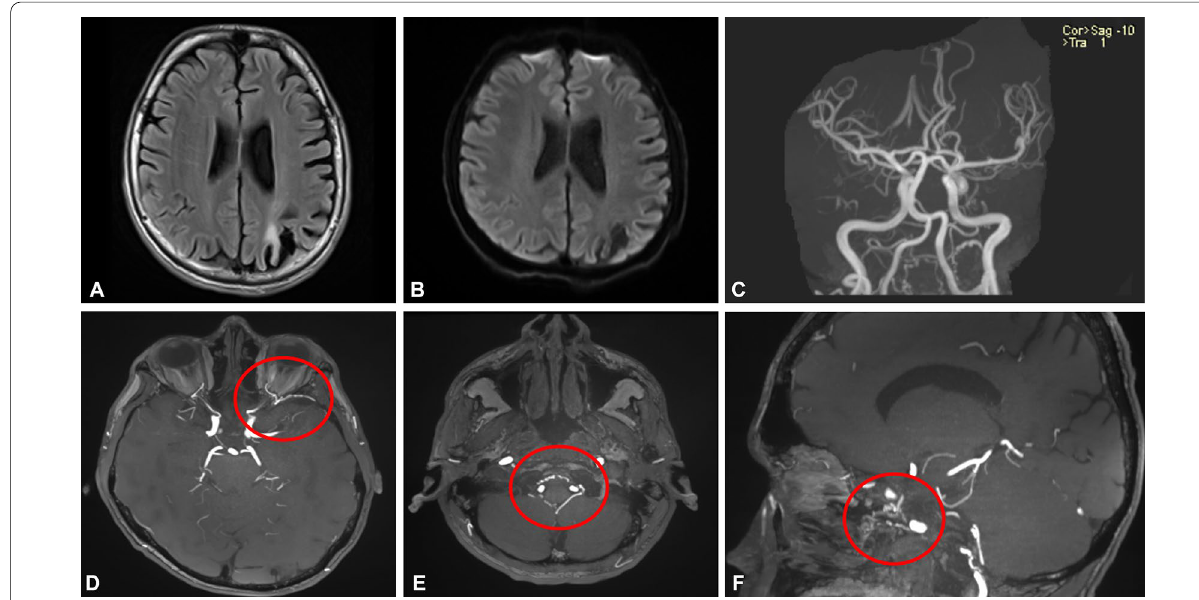
Fig. 1 Brain MRI/MRA of a patient with recurrent cerebrovascular events. Axial brain MRI with fluid‑attenuated inversion recovery (FLAIR) sequence showing an hyperintense lesion in the distribution of the left middle cerebral artery ( a ) without demonstrating restricted diffusion in the diffusion‑weighted imaging sequences ( b ), compatible with the patient’s history of prior ischemic strokes. No new lesions were identified on the diffusion weighted imaging sequence of brain MRI confirming the diagnosis of a transient ischemic attack. Large intracranial vessels appeared normal on brain MRA ( c ). Anastomosis between the left ophthalmic artery and left middle meningeal artery was identified on thin Maximum Intensity Projection (MIP) MRA (circle; d ). Meningeal branches in the area of craniocervical junction were dilated (circle; e ). Significant dilatation of the branches of the internal carotid artery in the pterygoid canal was also visualized (circle; f